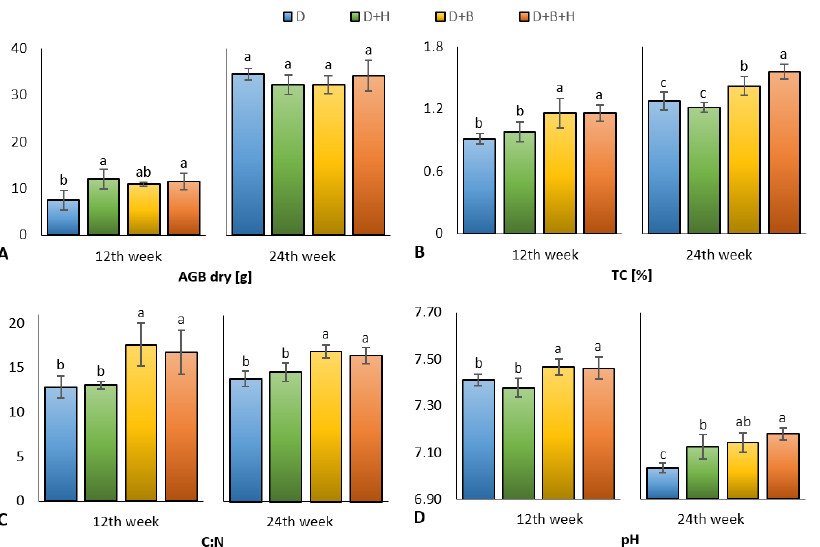
Figure 1. Dry aboveground biomass ( A ), total carbon ( B ), C:N ratio ( C ), and soil pH ( D ) under experimental variants in the first and the second part of pot experiment. Different letters indicate statistically significant differences of Tukey HSD post-hoc test at p ≤ 0.05.